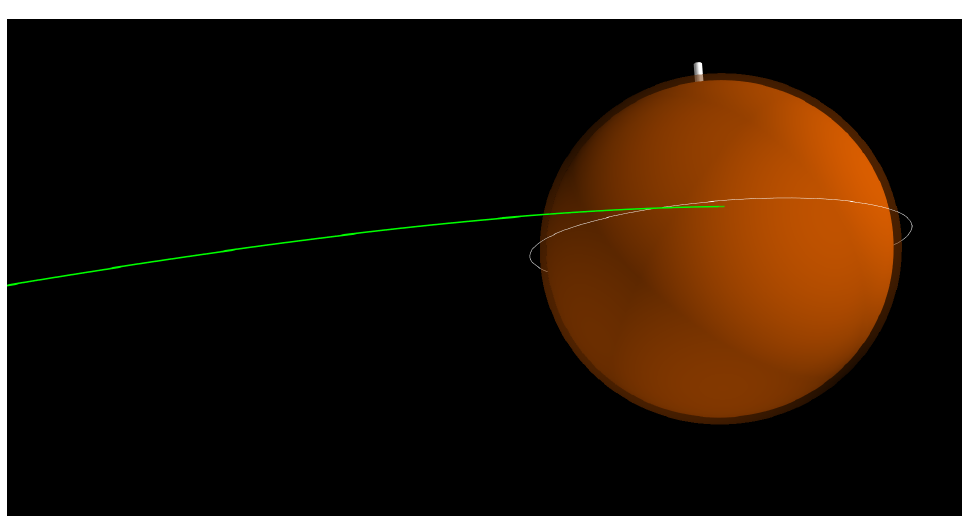
Figure 6. Approach trajectory of the Mars small satellite aerocapture vehicle. The white ring and the solid line indicate the equatorial plane and the direction of the north pole, respectively.